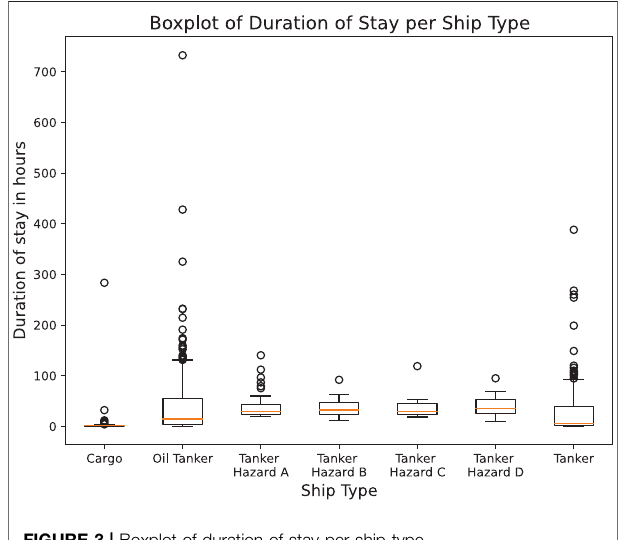
FIGURE 3 | Boxplot of duration of stay per ship type.